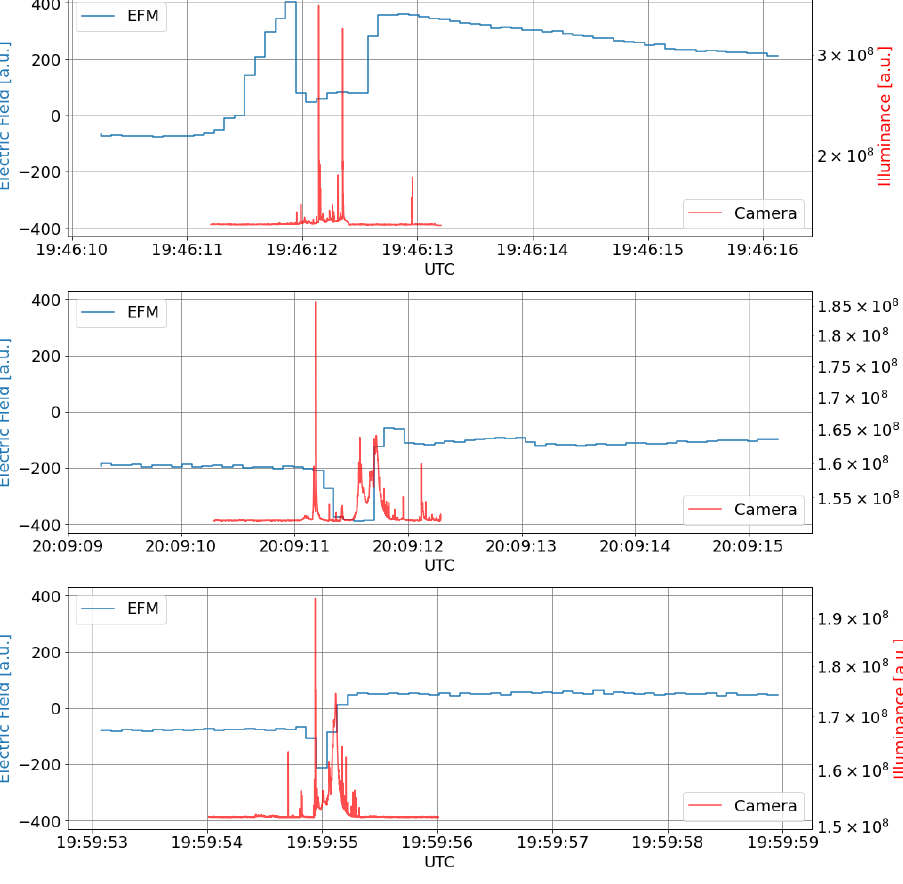
Figure 16. Details of the EFM data compared with camera